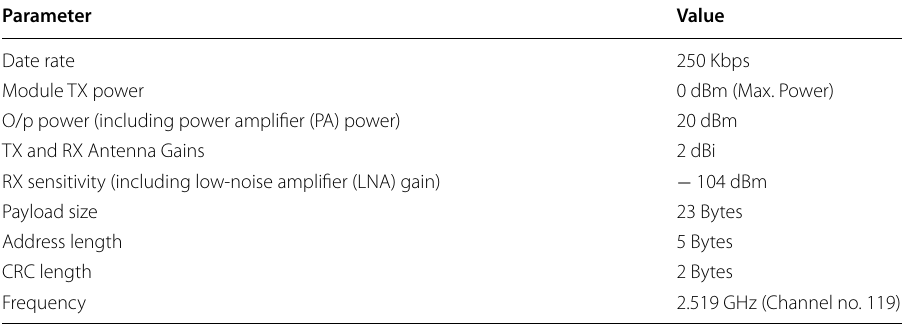
Table 2 Experimental